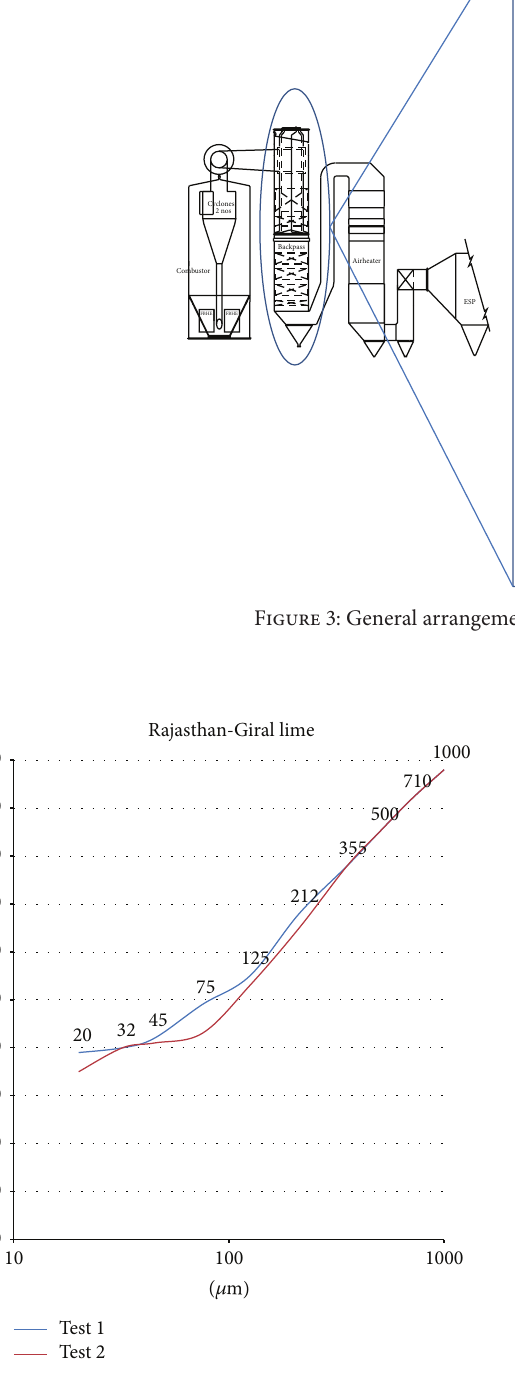
Figure 4: Shares of particles smaller than 50 𝜇 m in limestone sam-